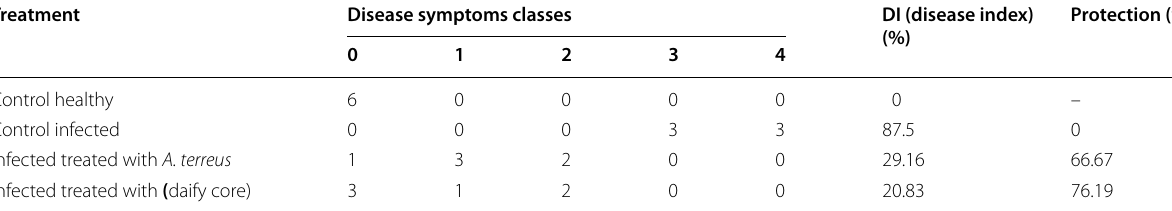
Table 1 Effect of A. terreus on A. solani early blight disease of S. melongena